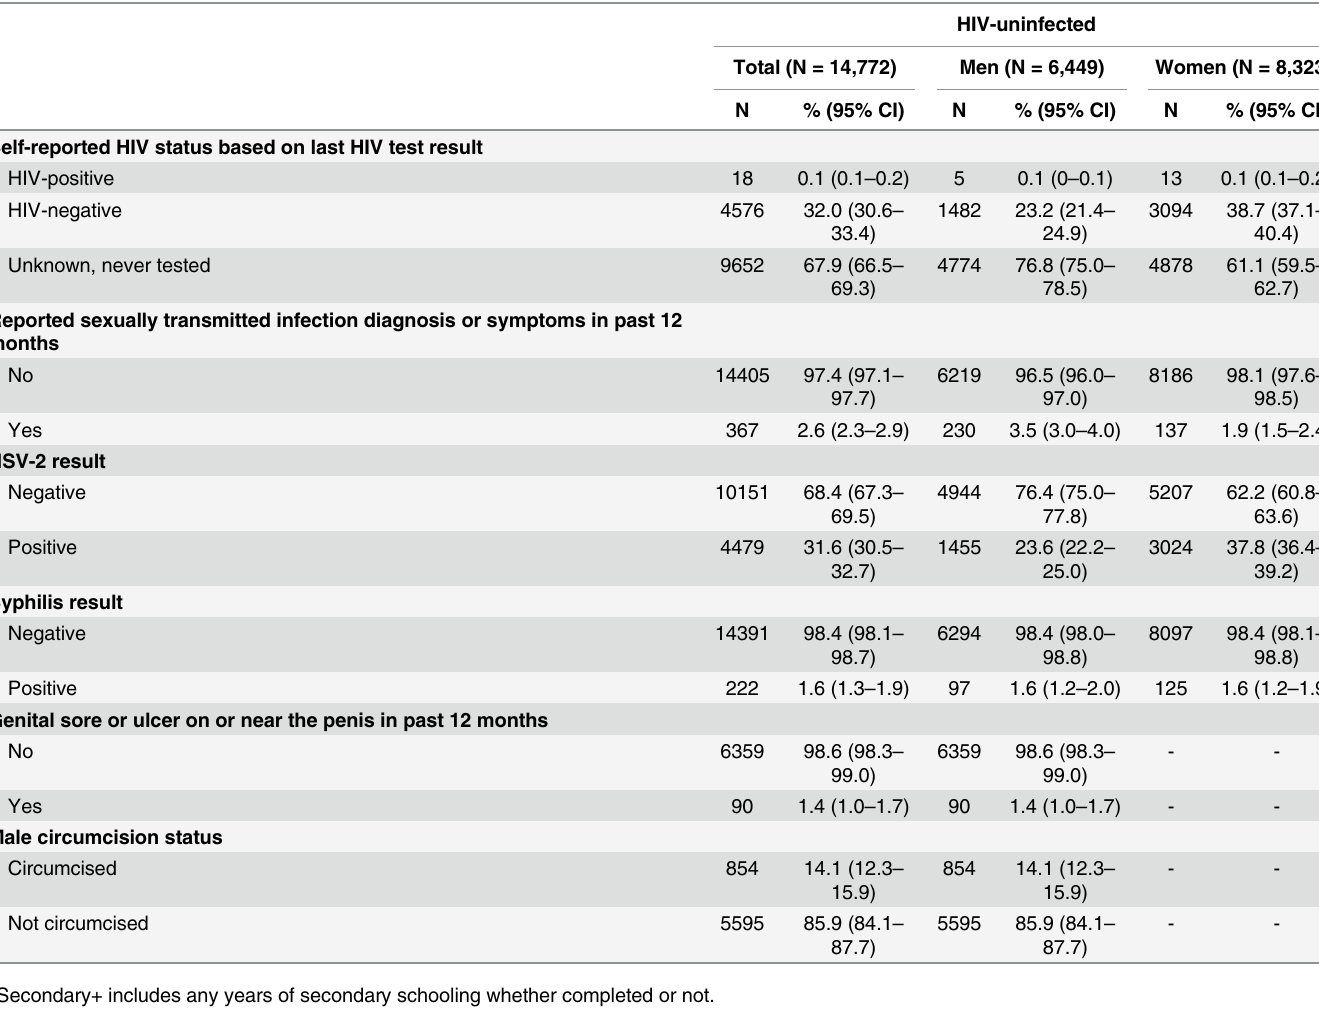
receiving their HIV-negative test result within the last 12 months. The median CD4+ T-cell count in this group was 1,108 cells/mm 3 ; 96.9% were married, and 38.2% were women, of whom 28.1% self-reported being pregnant at the time of the survey, and 41.8% had last tested for HIV infection as part of antenatal care within the year preceding the survey. Risk factors for recent and long-standing HIV infection In bivariate analysis, residence in Nairobi, Nyanza, and Rift Valley provinces; being currently married or widowed; reporting any syndrome or diagnosis of sexually transmitted infections (STI) in the past 12 months; and reporting a genital ulcer (men only) were significantly associ- ated with increased odds of recent infection and considered potential risk factors for